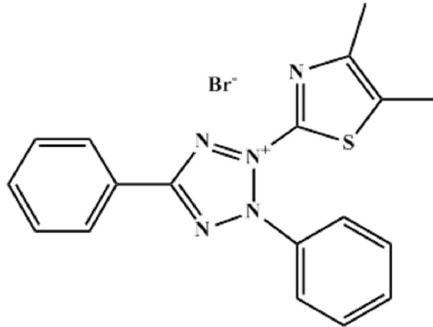
Figure 1. The Molecular structure of thiazolyl blue (MTT).